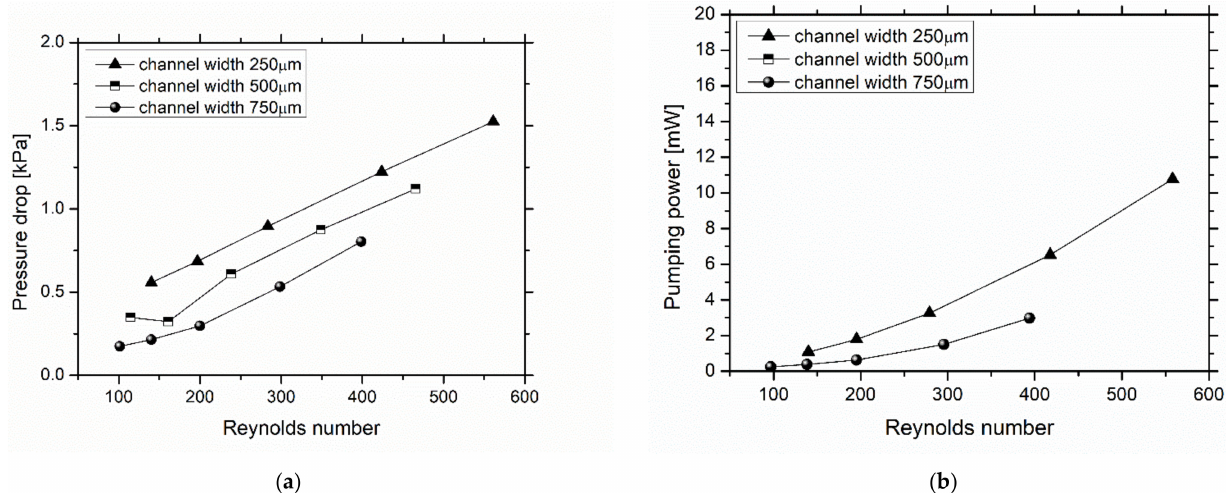
Figure 1. Effect of varying channel width on: ( a ) pressure drop and ( b ) pumping power for single- phase water flow in the heat sink.